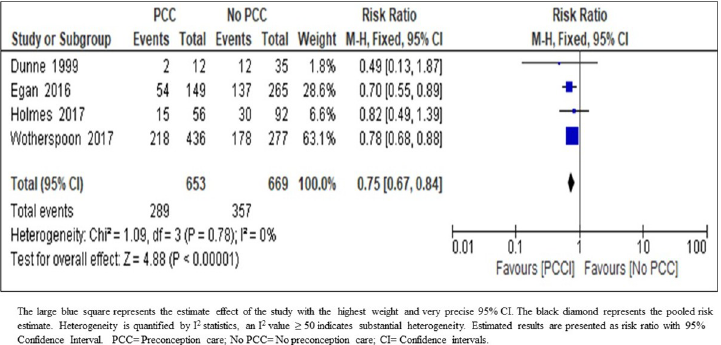
Fig 9. Risk ratio for neonatal intensive care unit admission from four studies of women with pre-existing diabetes mellitus who did or did not receive preconception care.